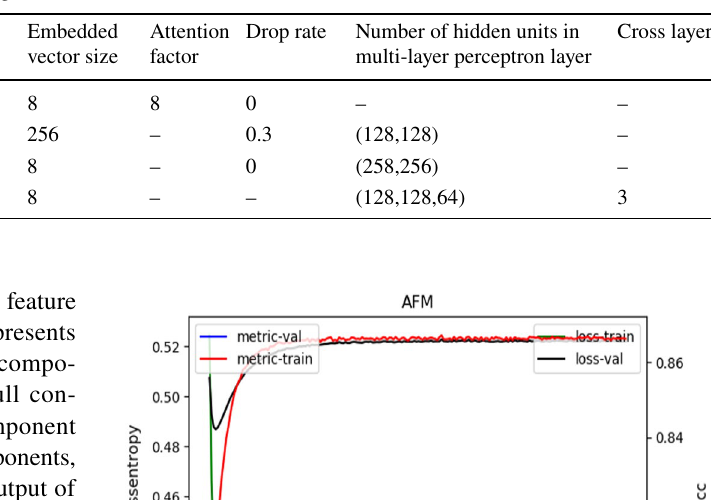
Table 1 Default values of AFM, DFM, DeepFM and DCN algorithms